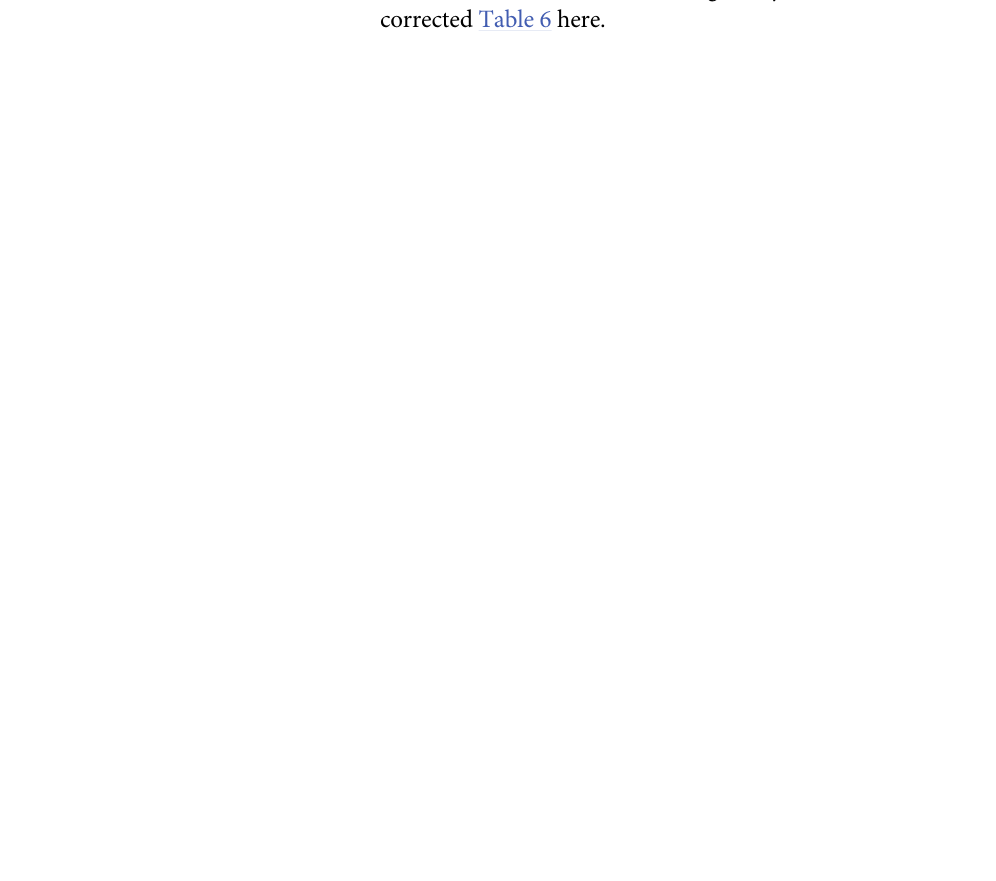
In Table 6, the column headings “ Adjusted HR ” should be “ Adjusted OR ” . Please see the corrected Table 6 here.